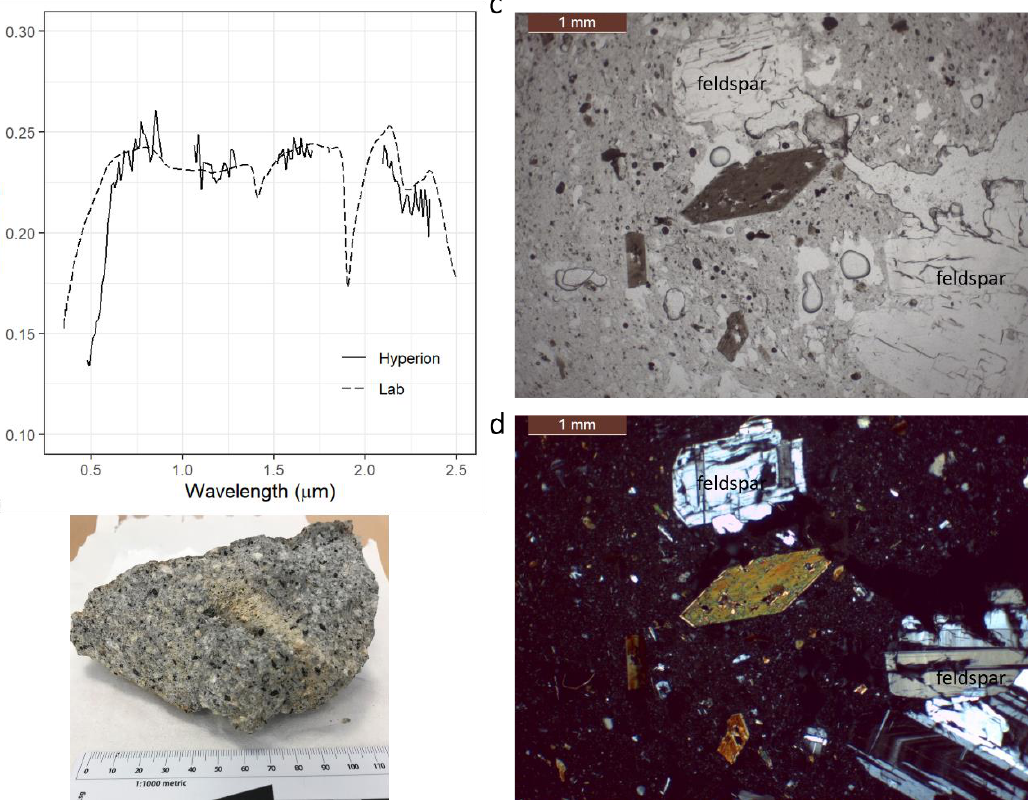
Figure 9. ( a ) Comparison of an EO-1 Hyperion spectrum to a spectrum acquired in the laboratory of feldspar-bearing rock from the Chanka dome (21°45 ′ 0 ″ S, 68°18 ′ 58 ″ W). ( b ) Image of the sample used for the measurement. White grains are feldspar. ( c ) Microscope image of a thin section of the sample. Feldspar grains are labeled. ( d ) Microscope image of a thin section of the sample in cross-polarized light. Twinning typical of plagioclase feldspars can be observed on feldspar grains.